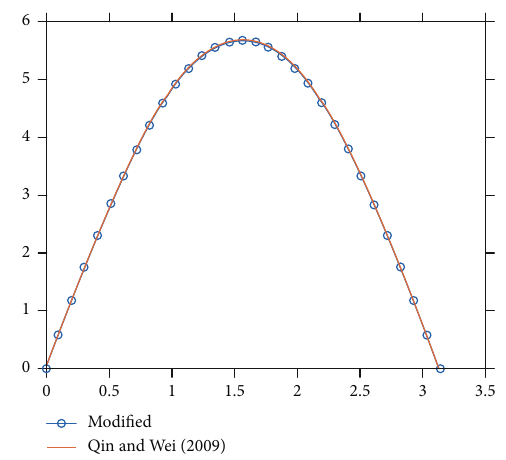
Figure 14: The variations of the system of equations (42) and the solution of the regularized system of equations (12) – (15) for p = 2 , k = 1 : 1 , α = 0 : 001 , and y = 0 : 6 .